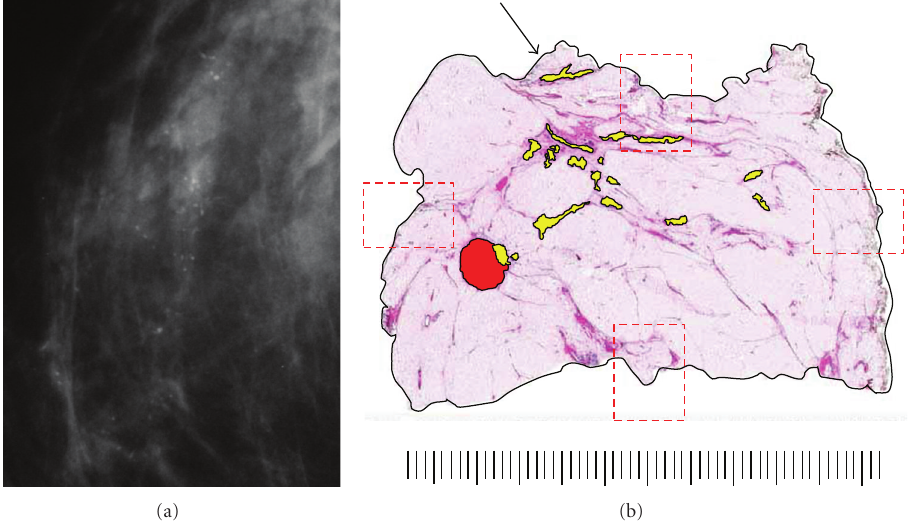
Figure 5: Analysis of case shown in Figure 4. (a) Asymptomatic 53-year-old woman with linear-casting calcifications on screening mammogram presented with no palpable abnormality. (b) Stereoguided biopsy showed grade 2 DCIS with necrosis. Core biopsy site is highlighted in red. DCIS is highlighted in yellow with maximum extent of 46mm. Specimen on gross examination was minimally fibrotic and negative for a palpable lesion or gross evidence of DCIS. Specimen radiography guided selection of tissue blocks and large-format section to best demonstrate extent of neoplasm and proximity to superior margin (Arrow). Presurgical MRI was not performed. Conventional margin section selection guided only by gross inspection and palpation could have missed DCIS encroachment on superior margin which measured 1.5 mm. Scale: small divisions = 1.0mm (H&E).